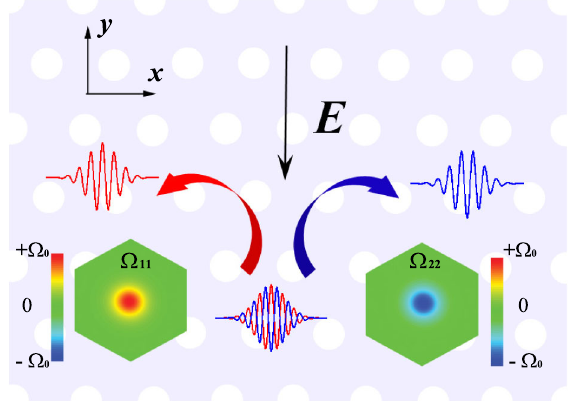
FIG. 6. Cartoon image illustrating different wave states ’ evo- lution under an external electric field under the influence of the Berry curvature. The value of the Berry curvature is shown in the color scale, plotted in the first Brillouin zone of the antidot graphene. The bottom left (right) shows the value of the diagonal matrix term Ω 11 ( Ω 22 ), with the peak value at the Γ point of the antidot reciprocal lattice. The red wave represents the case of j η 0 1 j 2 > 1 = 2 ; it travels to the left as v x < 0 . The blue wave represents the case of j η 0 1 j 2 < 1 = 2 ; it travels to the